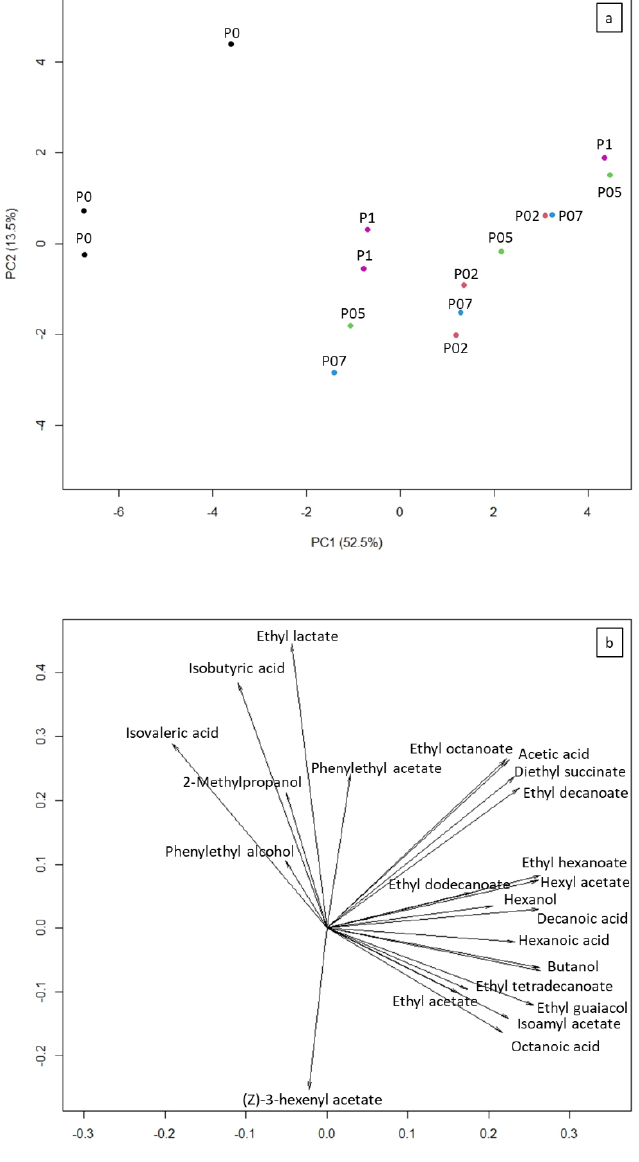
Figure 1. Score (upper graph ( a )) and loading (lower graph ( b )) plots obtained with the principal component analysis (PCA). In the score plot, black points represent the control samples produced at atmospheric pressure (i.e., 0 bar—the P0 samples), red points the P02 samples (i.e., 0.2 bar), green points the P05 samples (i.e., 0.5 bar), blue points the P07 samples (i.e., 0.7 bar), and purple points the P1 samples (i.e., 1.0 bar).